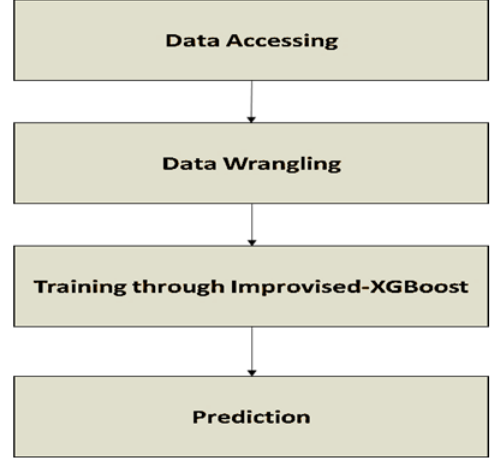
Figure 1. Improvised_XGBoost classifier process